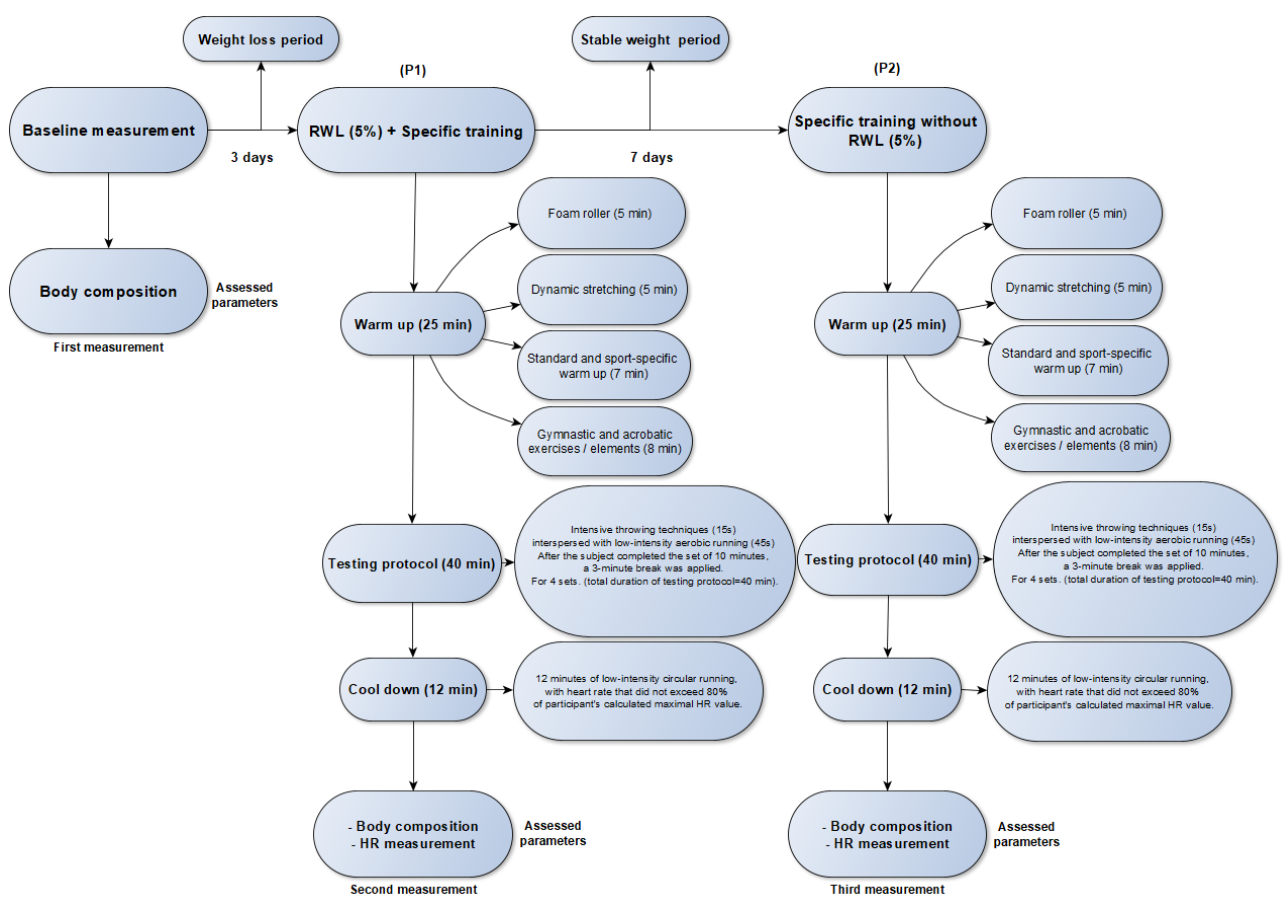
Figure 1. Experimental procedure design.